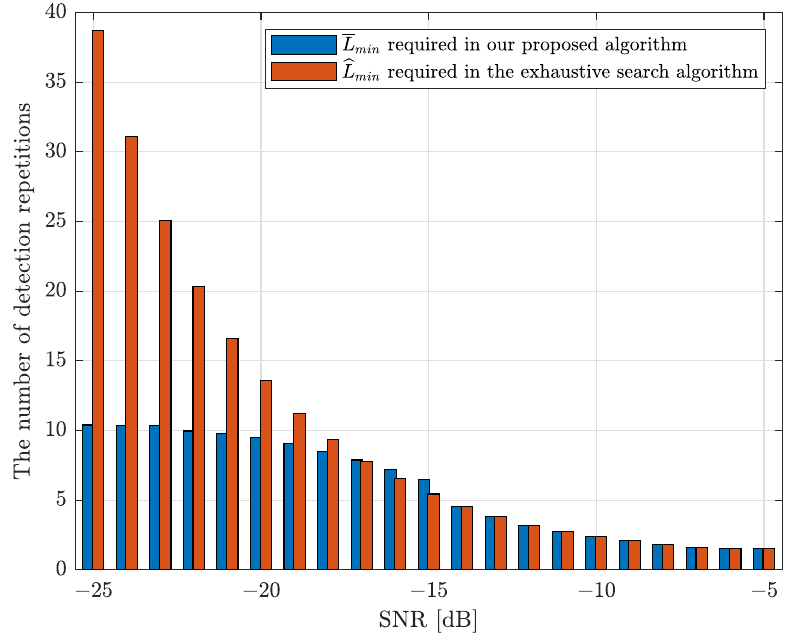
Figure 4. Comparison of the minimum number of detection repetitions between our proposed method and the exhaustive search algorithm, M =